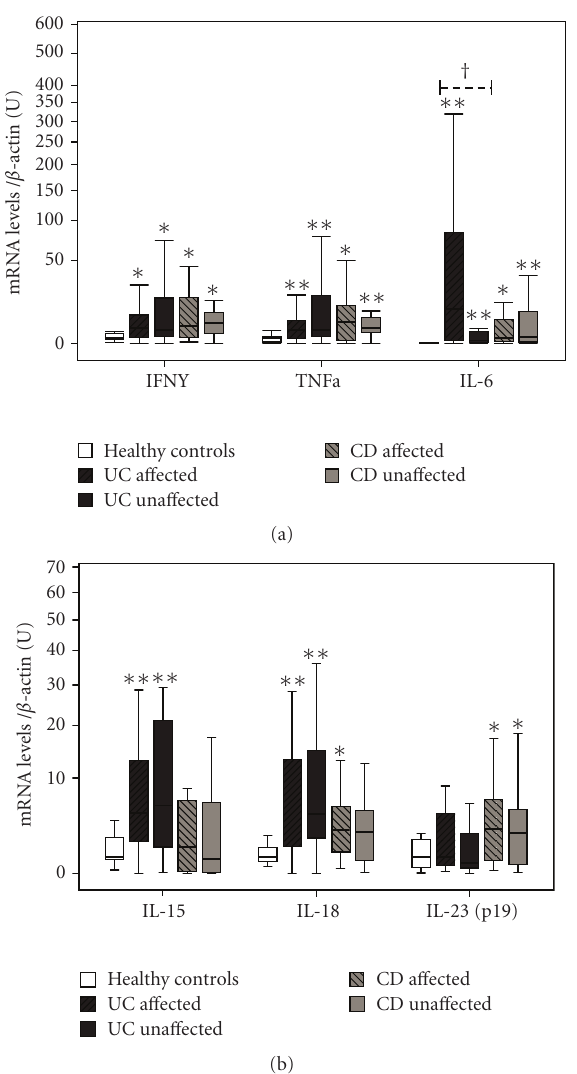
Figure 3: Di ff erences in mRNA levels of those proinflammatory cytokines which are increased only in the a ff ected areas of IBD. Statistical di ff erences compared to healthy controls ∗ P < . 05 and ∗∗ P < . 001, and between a ff ected and una ff ected areas from the same pathology † P < . 05 †† P < . 001 . U: arbitrary